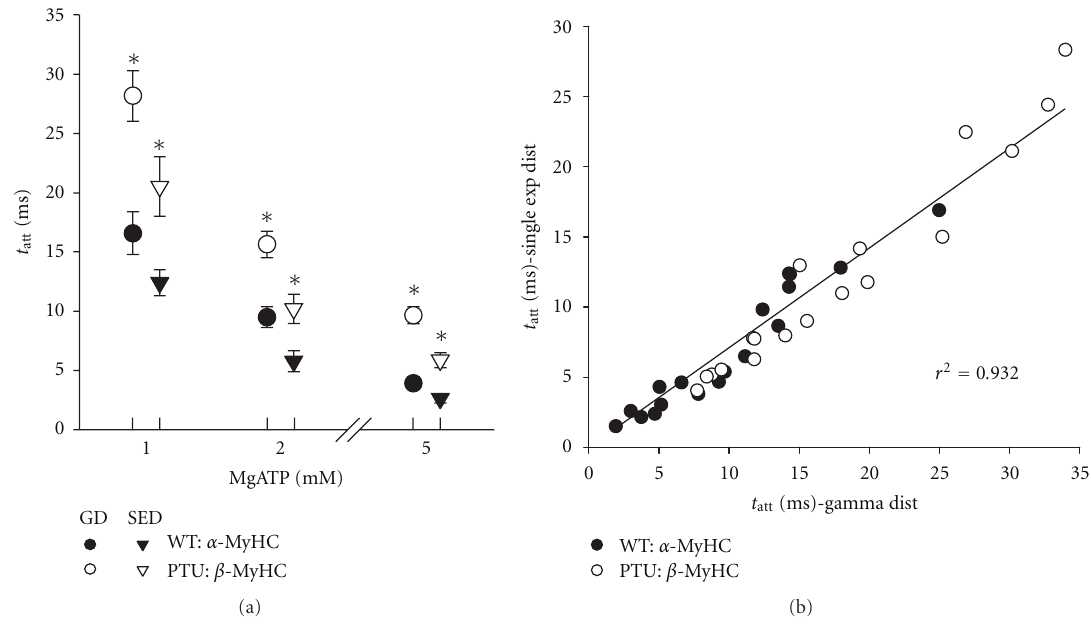
Figure 7: Mean time of crossbridge attachment. (a) The mean time of crossbridge attachment using both models of PDF t a longer t att for β -MyHC and a prolongation in t att as MgATP was reduced. The two models agreed qualitatively in these respects, but did not agree quantitatively as estimates using the gamma distribution (GD) model were ∼ 40% higher than those using the single exponential distribution model (SED). (b) Values for t att using the two models correlated strongly. Despite the relative di ff erences in the estimates of t att , either model produces similar results for comparing the e ff ects of isoform and MgATP. ∗ P < 0.05 by t -test between MyHC isoforms at same